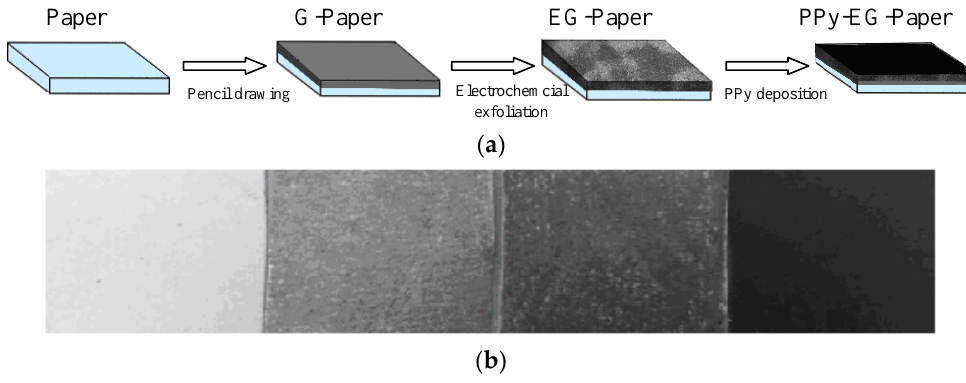
Figure 1. ( a ) Schematic of fabrication process of the PPy-EG-paper; and ( b ) photographs of the blank paper, G-paper, EG-paper, and PPy-EG-paper.